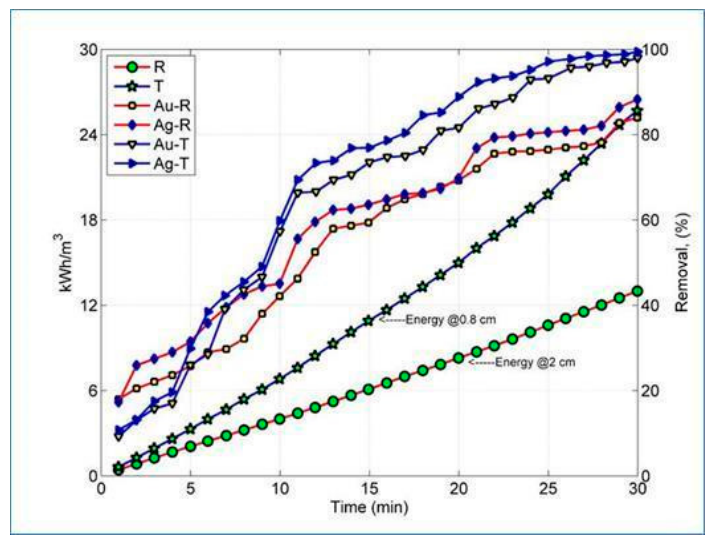
Figure 5. Energy consumption and percent removal of metals versus t r obtained in the tests at constant voltage. Table 2. Parameters and results of tests P, Q, R, and